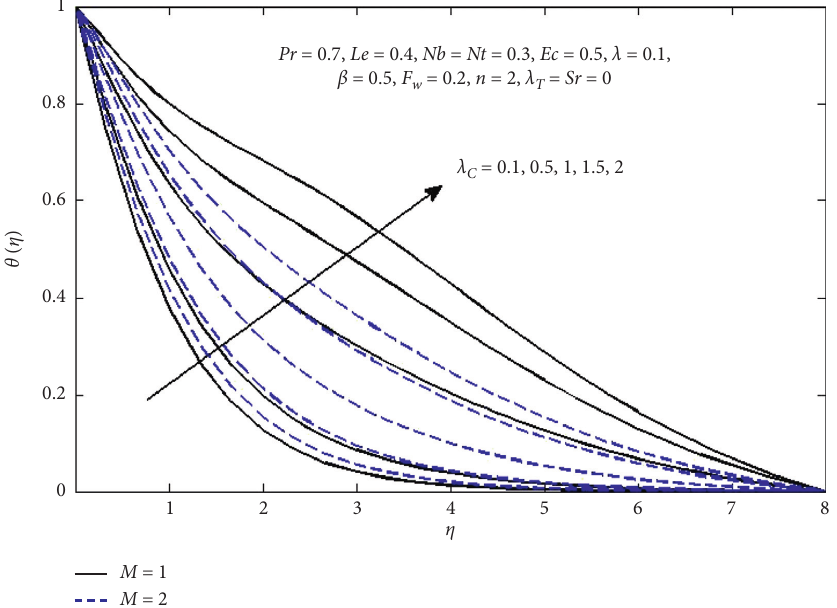
Figure 3: Variation of temperature θ concerning η with various values of λ